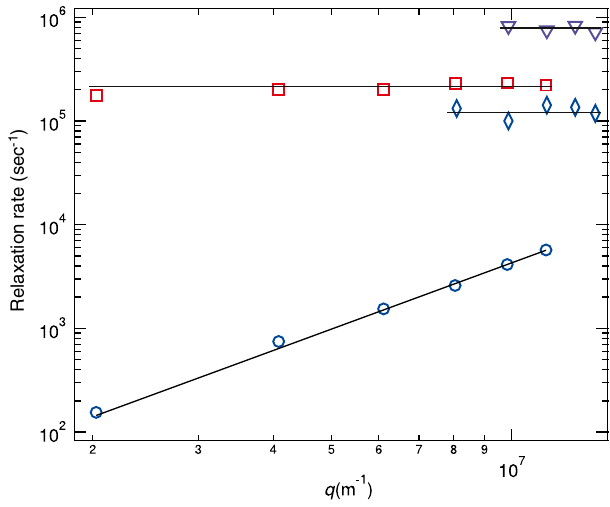
FIG. 5. Dependence of the relaxation rates of the fluctuation modes detected in geometry G2 on the magnitude of the scattering vector q . Circles and squares correspond to relaxation rates Γ n 2 and Γ p 2 of the hydrodynamic director and nonhydrody- namic polarization modes detected in scattering geometry G2 in ¼ 25 °C). The scatter- the middle of the nematic phase ( T − T TB ing angles θ s range from − 5 ° to 45° for fixed incident angle θ ¼ 15 ° (see definitions in Fig. 2, top right). The slope of the line i through the data on the log-log plot for Γ n 2 is 2, indicating Γ n ∼ q 2 . Diamonds and triangles correspond to relaxation rate Γ t 2 2 of the nonhydrodynamic pitch axis fluctuations at temperatures T − T ¼ − 0 . 85 °C and − 8 . 0 °C, respectively, in the N phase. TB TB These data are limited to higher q (or θ s in the range 25° or 35° to 65°) due to a large component of background scattering at lower q , whose effect is exacerbated because of the low scattering intensity from fluctuations in the N phase in the G2 TB